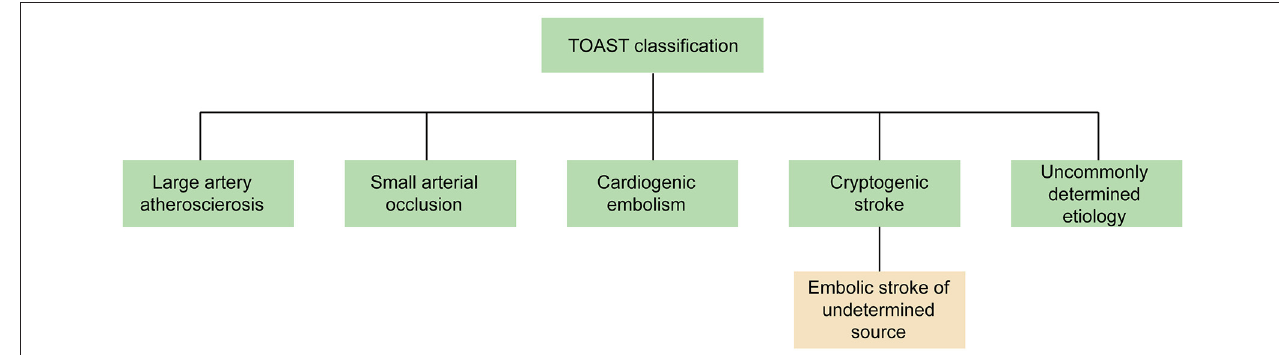
FIGURE 1 | The classification of IS in TOAST. The term “ESUS” is a more specific and clinically useful concept to describe most of CS patients. TOAST, Trial of ORG 10172 in Acute Stroke Treatment; ESUS, embolic stroke of undetermined source; CS, cryptogenic